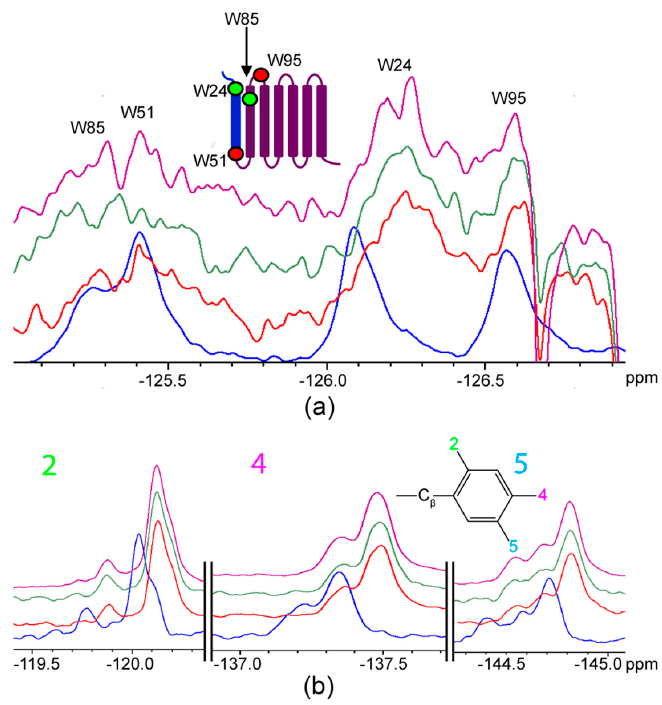
Table 2. 19 F chemical shift perturbation ( Δδ ) relative to control sample in absence of binding partner for TM1-3:F*-ap-13 interactions.